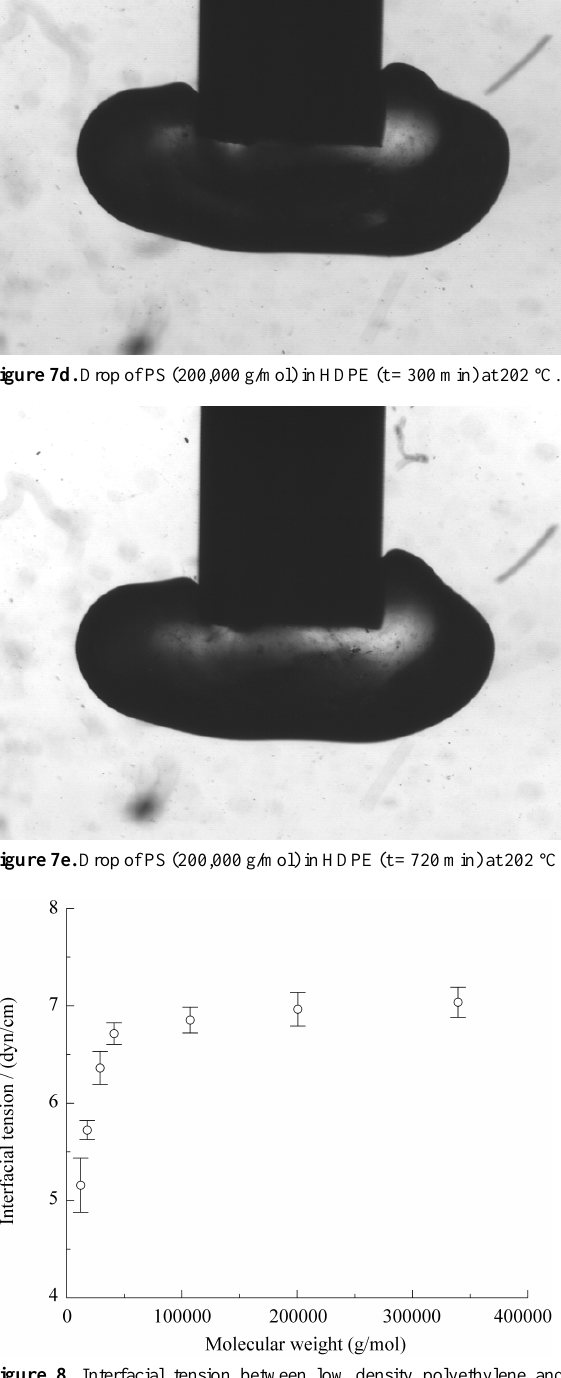
Figure 8. Interfacial tension between low density polyethylene and polystyrene as a function of molecular weight of